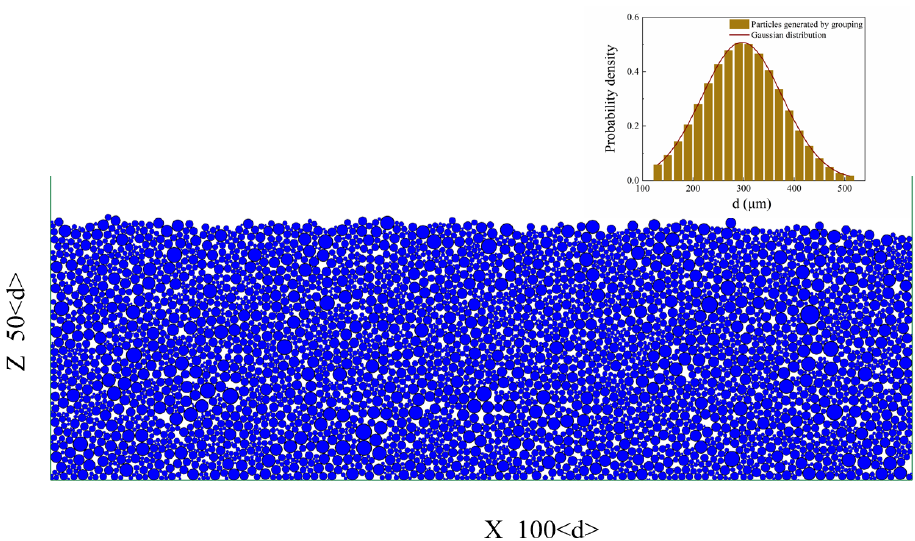
Figure 3. The initial loose sand bed consists of 5000 mixed grains follows a Gaussian